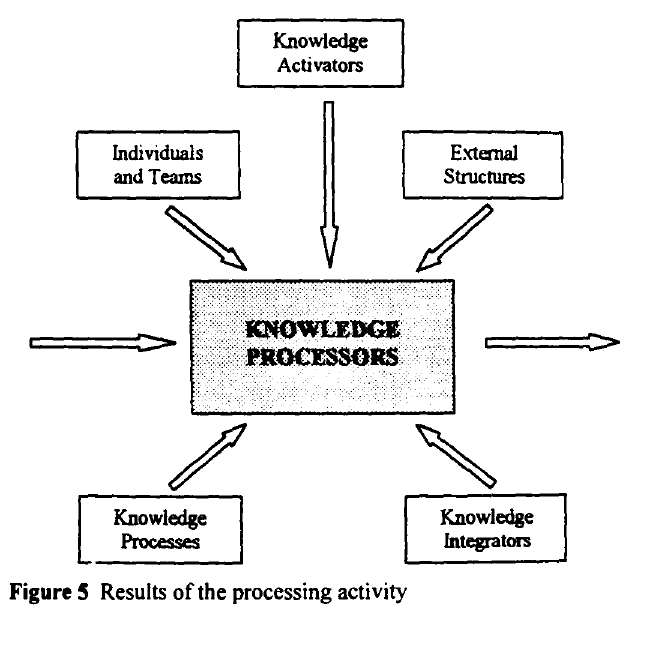
Figure 5 Results of the processing activity